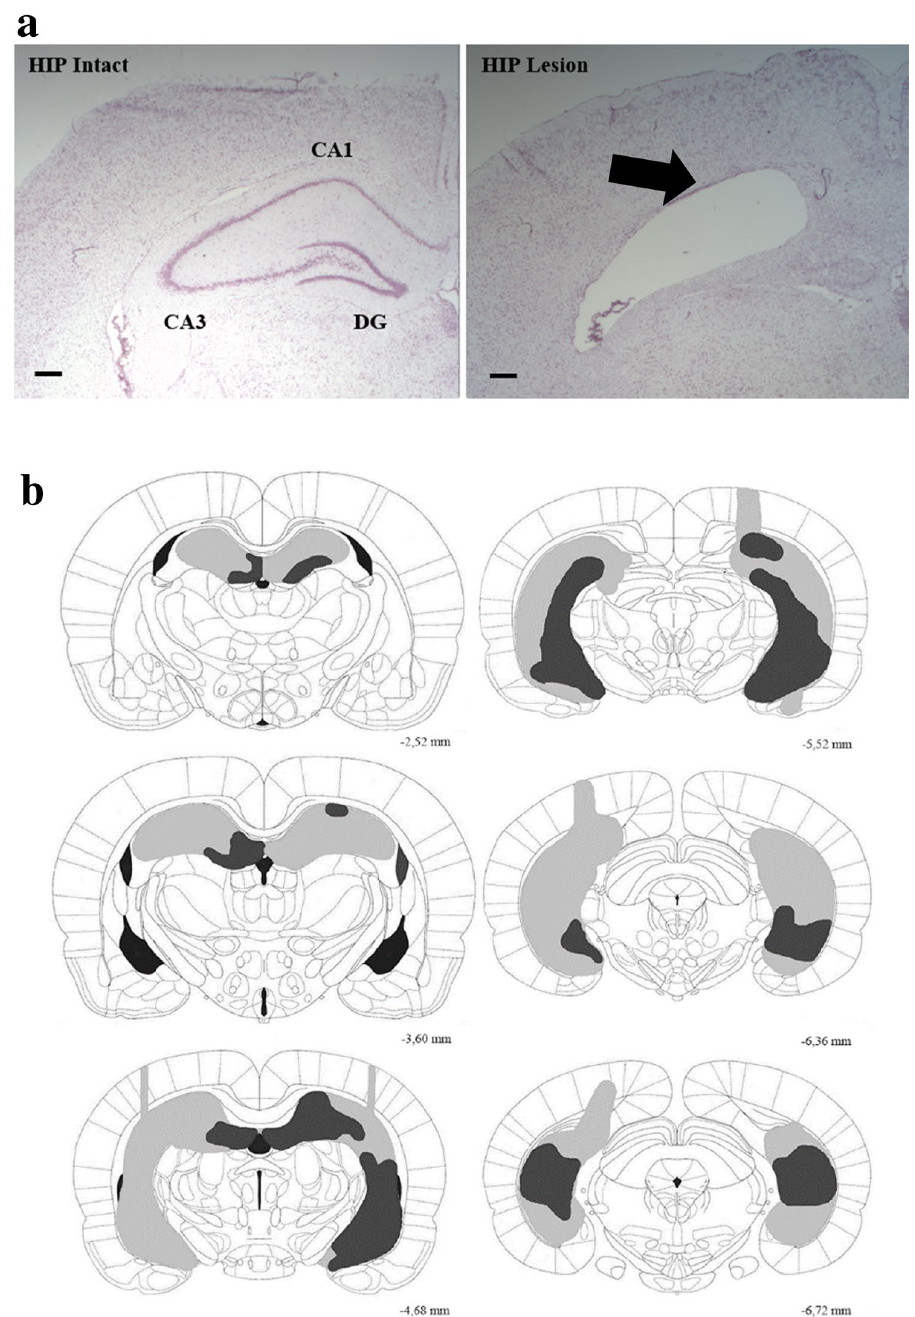
Figure 2. Extent of the HIP lesion. ( a ) Photomicrographs of Nissl stained coronal sections of HIP intact (left) and HIP lesion (right) rats. Scale bar 200 µm. ( b ) Representation of the HIP lesion, black arrow points to the damaged area. Light grey: largest lesions. Dark grey: smallest lesions. Approximately 76% of HIP was lesioned in